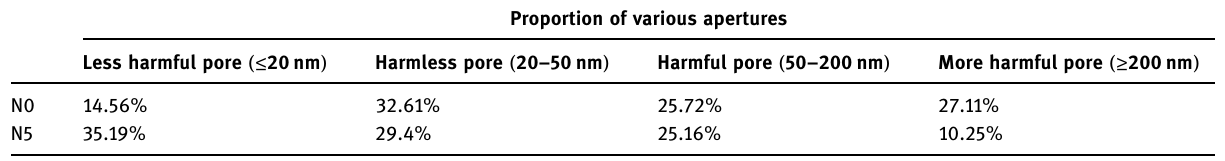
Proportion of various